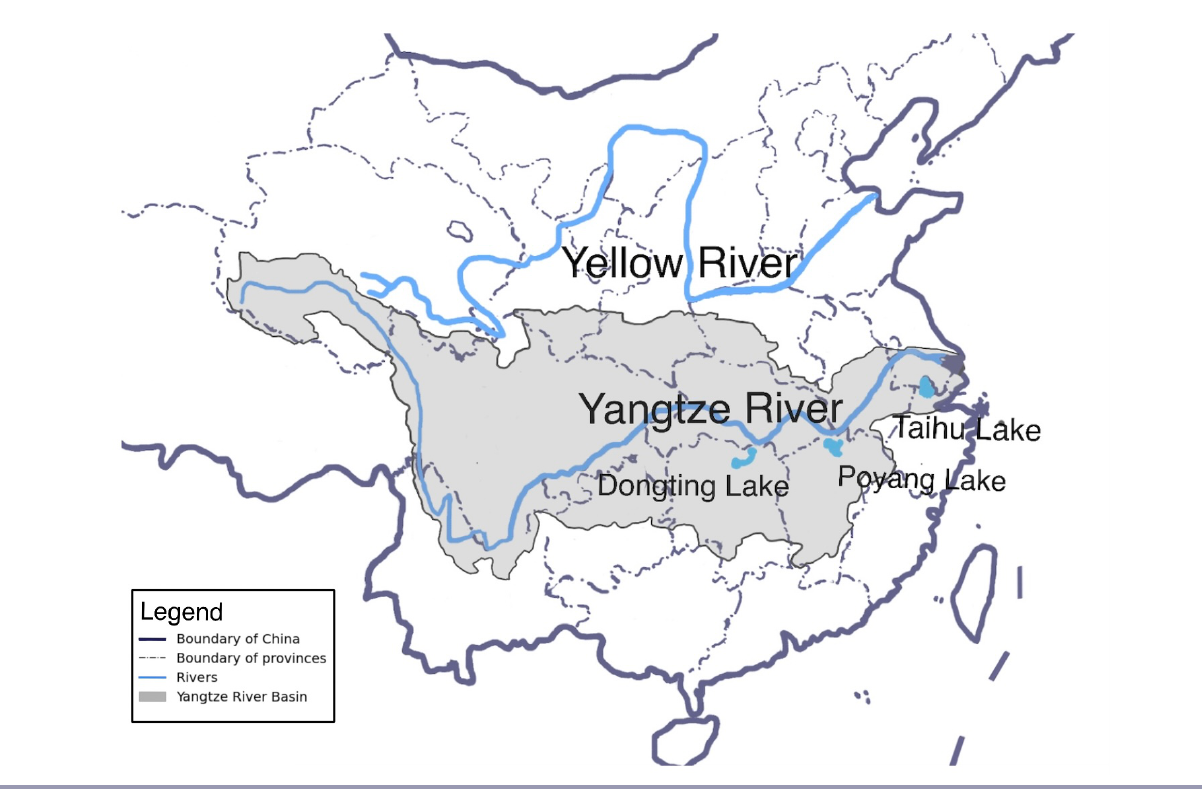
Fig. 1. Yangtze River